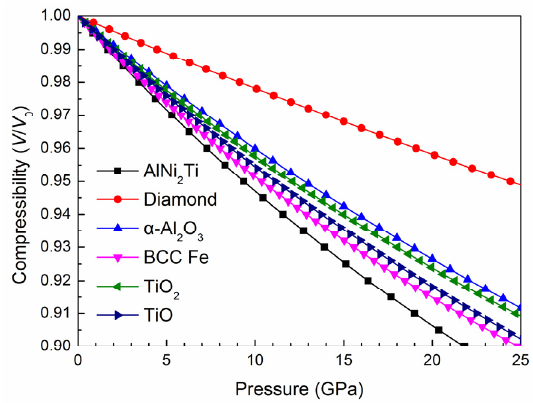
Figure 3. Compressibility characterized by normalized volume versus pressure of AlNi 2 Ti, as well as diamond, α -Al 2 O 3 , BCC-iron, TiO 2 and TiO for comparison.